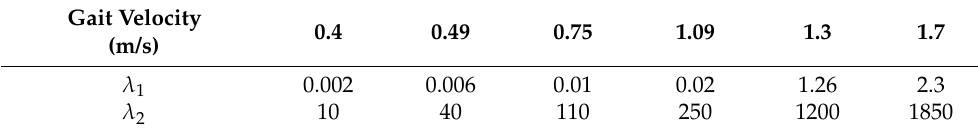
Figure 2. The test statistics of the accelerometers and gyroscopes in the three gait modes. Table 1. The threshold of the proposed zero velocity detector at different gait